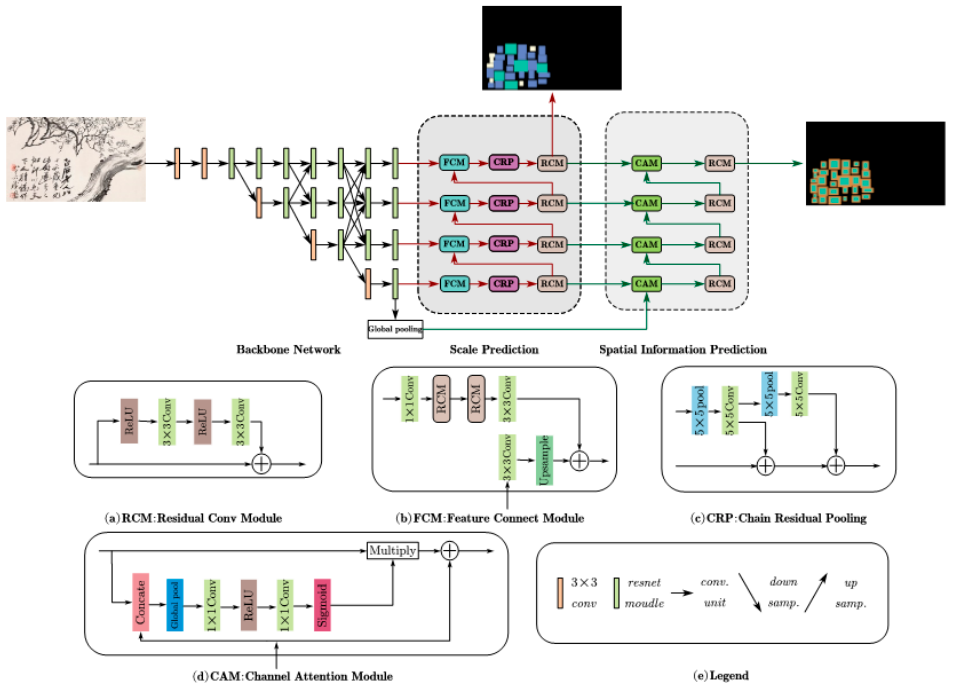
Figure 5. Calligraphy character detection network. In the output feature map of scale prediction, green, blue and white represent three character maps of different sizes: large, medium and small. In the output feature map of spatial information prediction, green represents the character core region, and orange represents the character boundary.